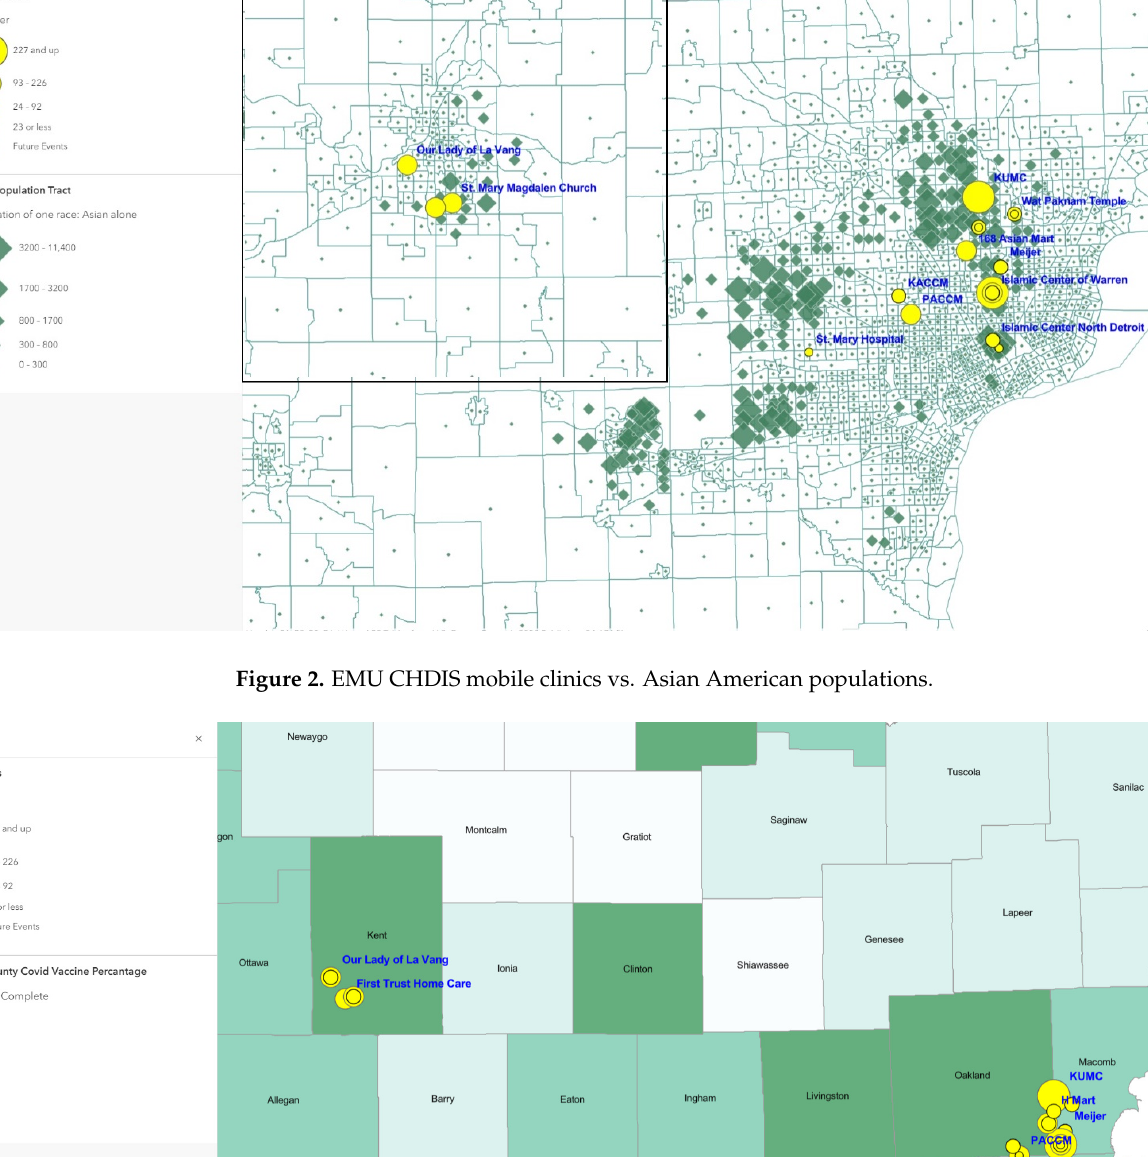
Figure 1. EMU CHDIS mobile clinics vs. COVID-19 vaccination provider locations.